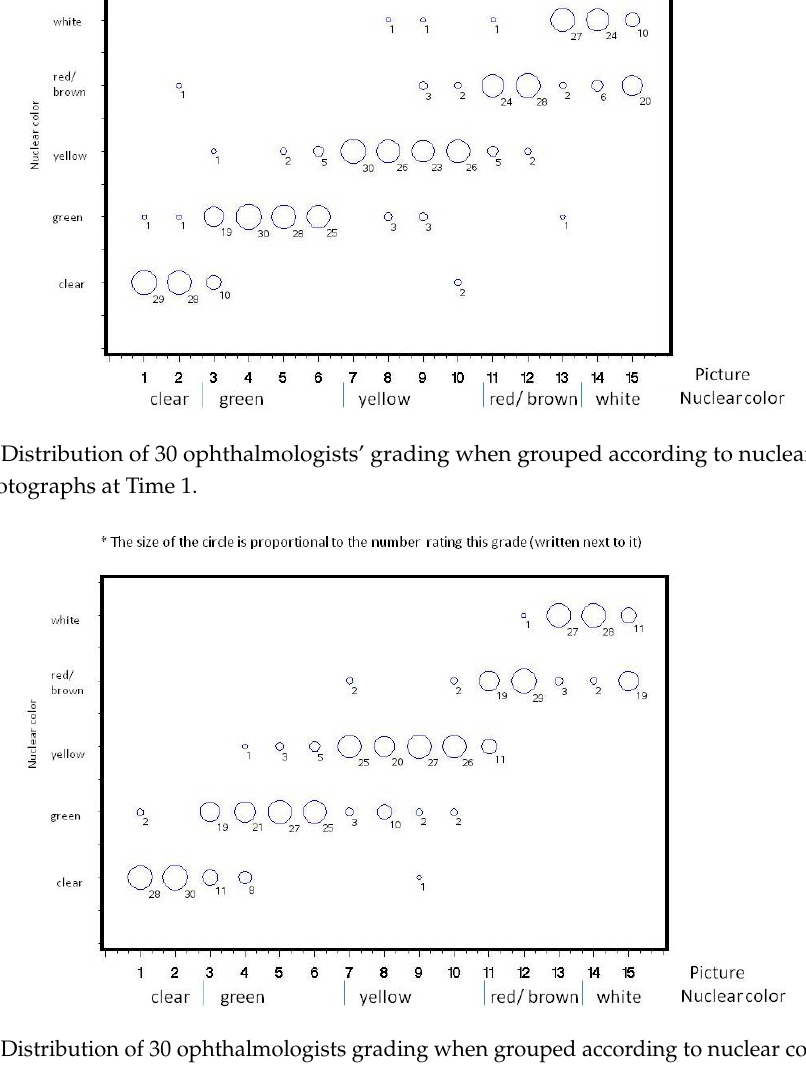
Figure 5. Distribution of 30 ophthalmologists grading when grouped according to nuclear color for the 15 photographs at Time 2.